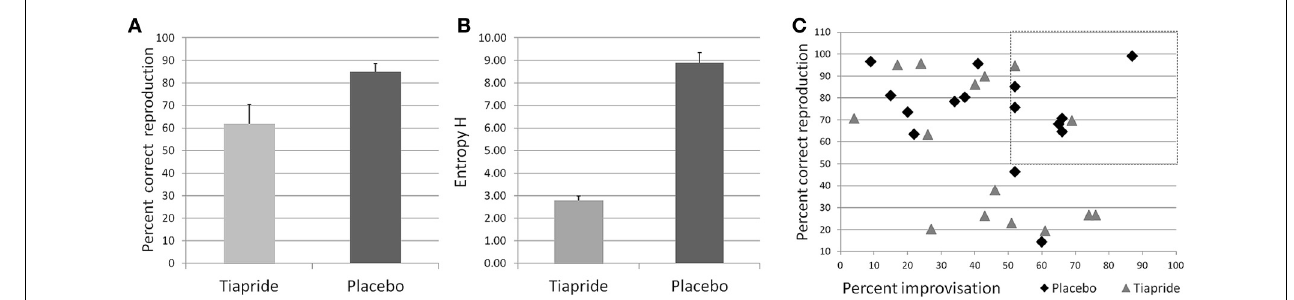
FIGURE 3 | Performance in the motor sequence task. (A) Percent correct keypresses in reproduction of the learned motor sequence. (B) Total Entropy H produced by the groups during improvisation over the motor sequence. Higher values indicate a higher level of improvisation. (C) Scatterplot of the